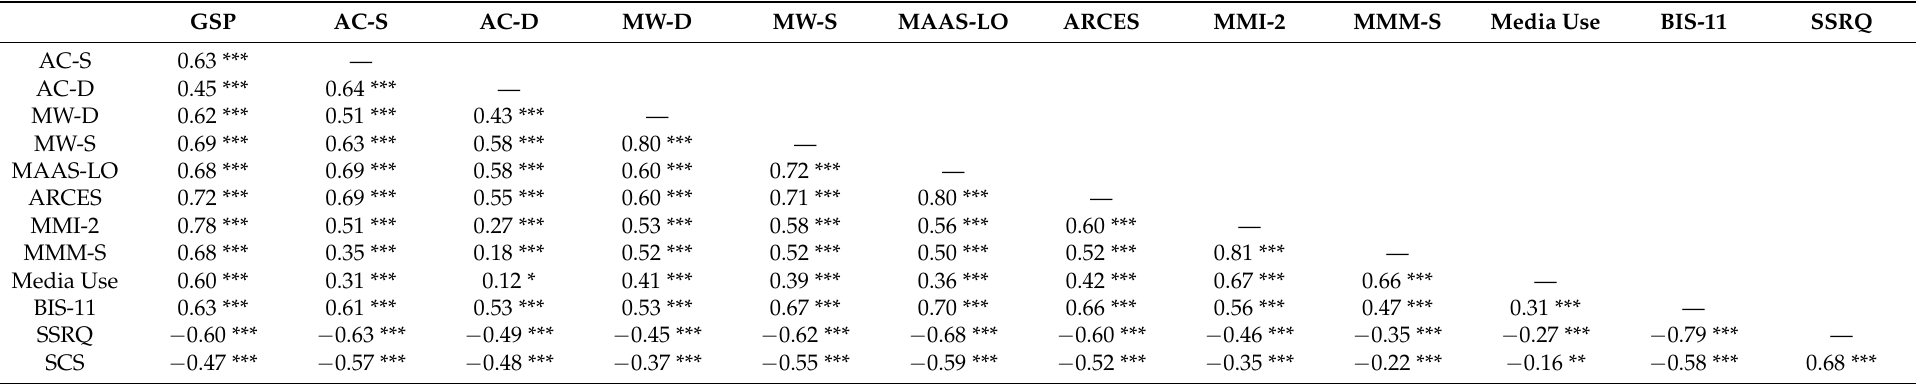
Table 2. Pearson correlation coefficients between phubbing behavior and everyday attentional failures, media multitasking and media use, and psychosocial and personality variables ( N = 373). GSP BIS-11 SSRQ